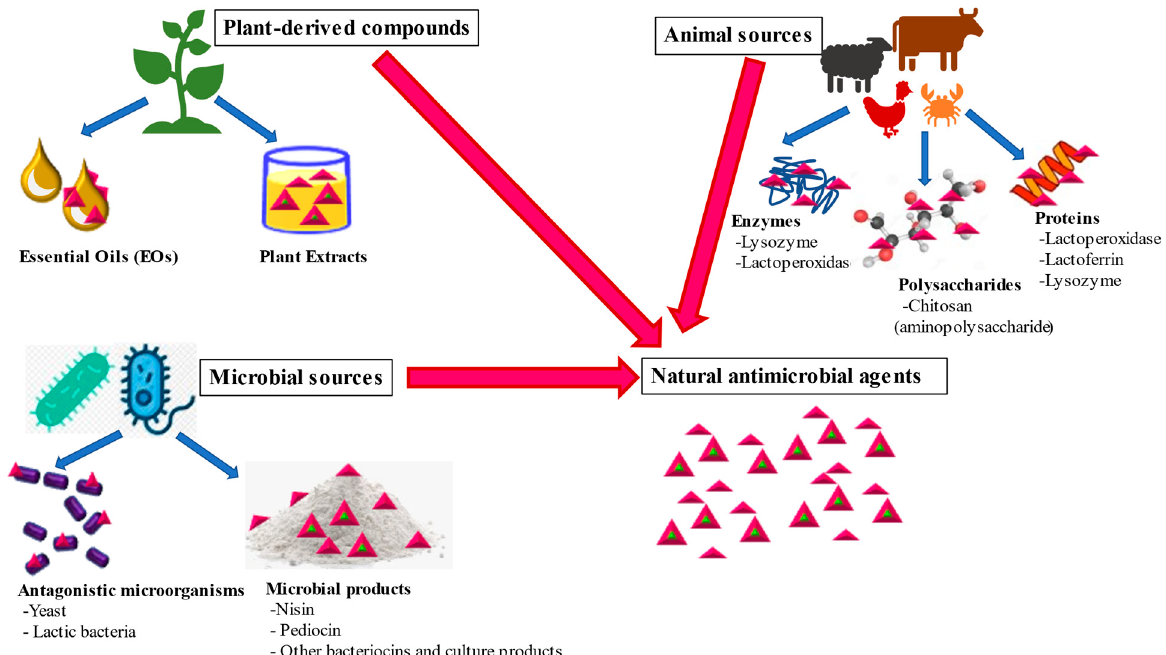
Figure 1. Sources of natural antimicrobial agents as additives in edible packaging systems.